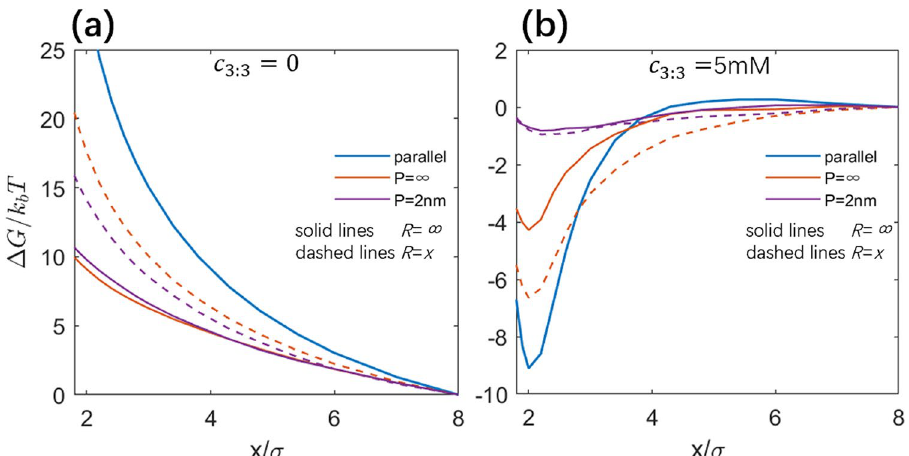
Figure 5. ( a , b ) Potentials of mean force between two PEs with different intrinsic persistence lengths P : c 3:3 = 0 ( a ), c 3:3 = 5 mM ( b ). Solid lines denote the calculations in the absence of cylindrical confinement and dashed lines denote those for R = x .